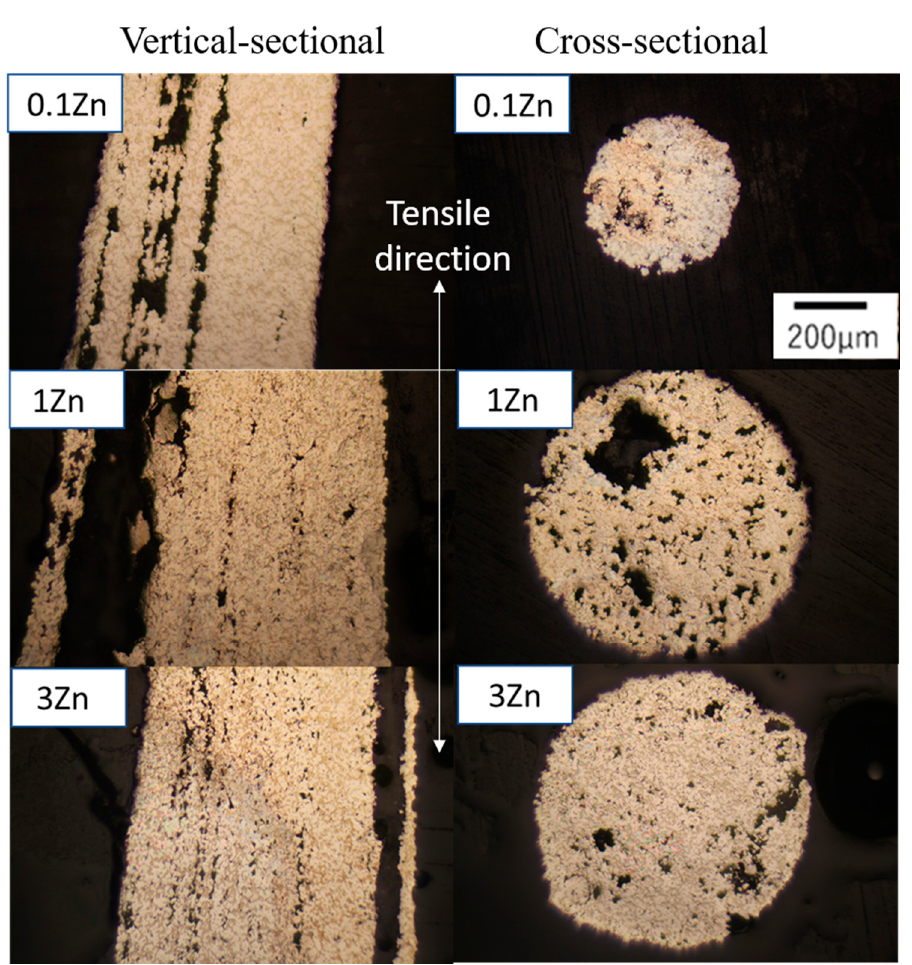
Figure 12. Vertical and cross-sectional optical microscopic images of various Sn-40Bi-Zn alloys after the tensile tests. Table 2. Solidus and liquidus temperatures of the Sn-40Bi-Zn